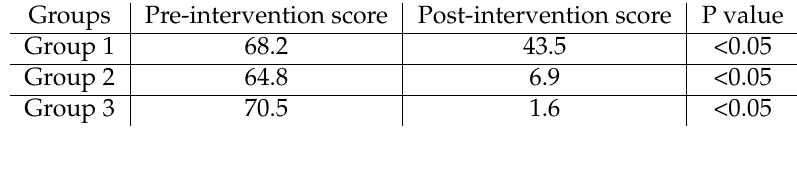
Table 1. Comparison of foot function index score